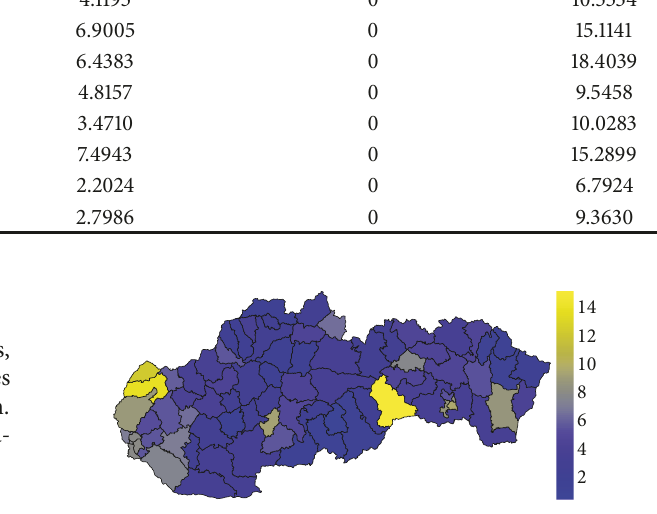
Figure 1: The average annual standardised mortality rate of the female sex in the individual districts of the Slovak Republic for the whole period.